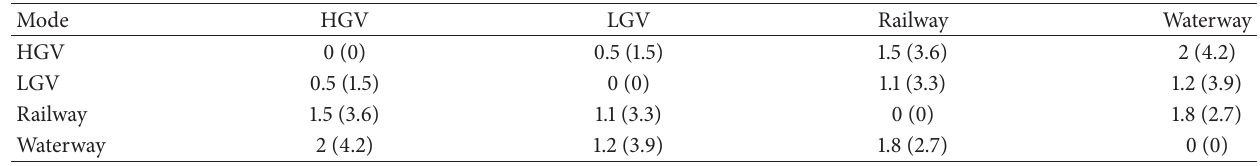
Table 3: The transfer time and cost at the general logistics